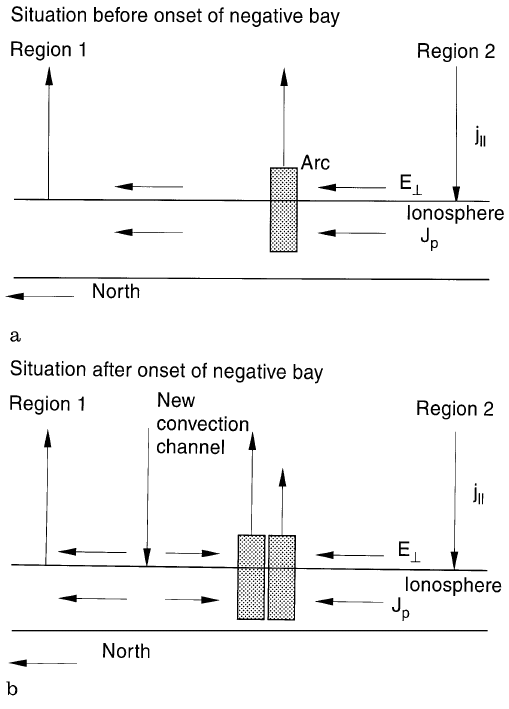
Fig. 9a,b. Sketch of the ionospheric-magnetospheric current system a before and b after the onset of the negative bay in the Troms (cid:249) ground-magnetometer data of Fig.